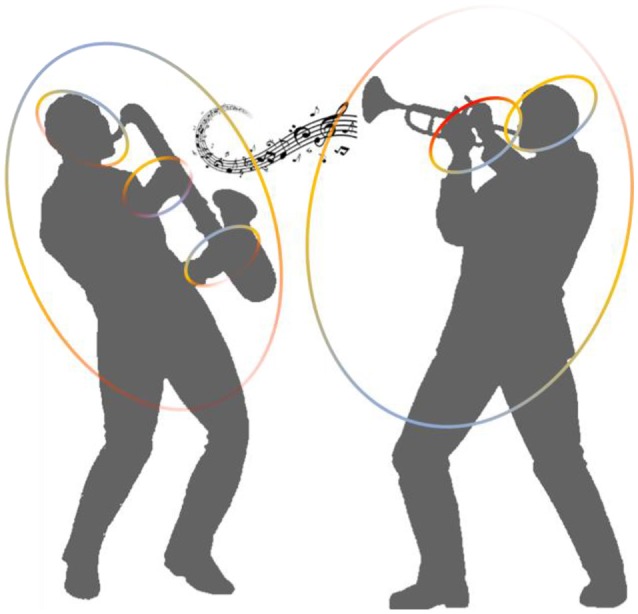
Representation of the visual and auditory sequential information exchange in musical improvisation. Adapted from Walton et al. (2015), (see also Kugler and Turvey, 1987).